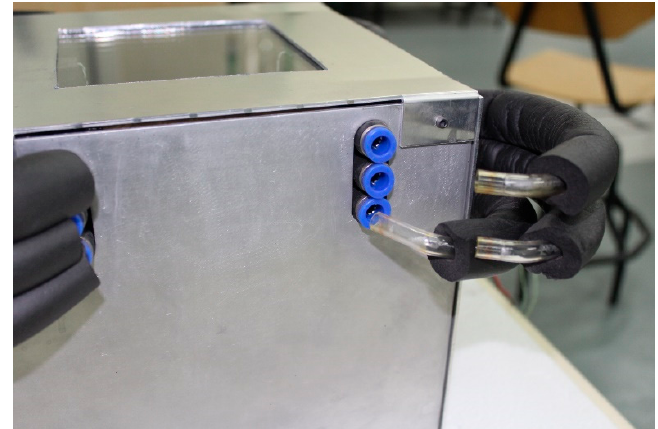
Figure 8. A view from the side of the module. The pipes are disconnected to show the type of high-pressure connectors used. Furthermore, the pipes are insulated to avoid loss of heat. The flow pattern within the absorber can be easily varied using this setup.